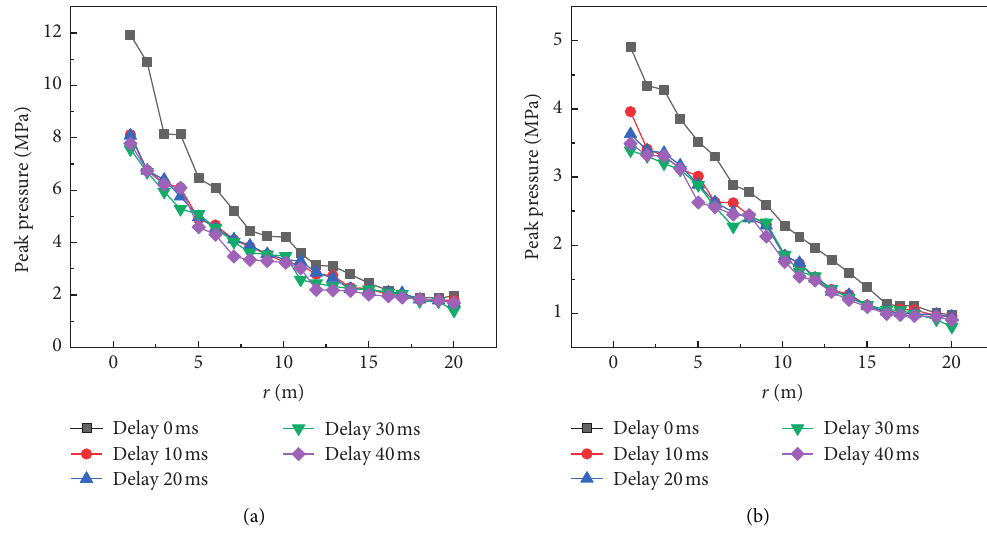
Figure 8: The attenuation curve of water hammer wave on the minimum resistance line. (a) 5m. (b) 20m.